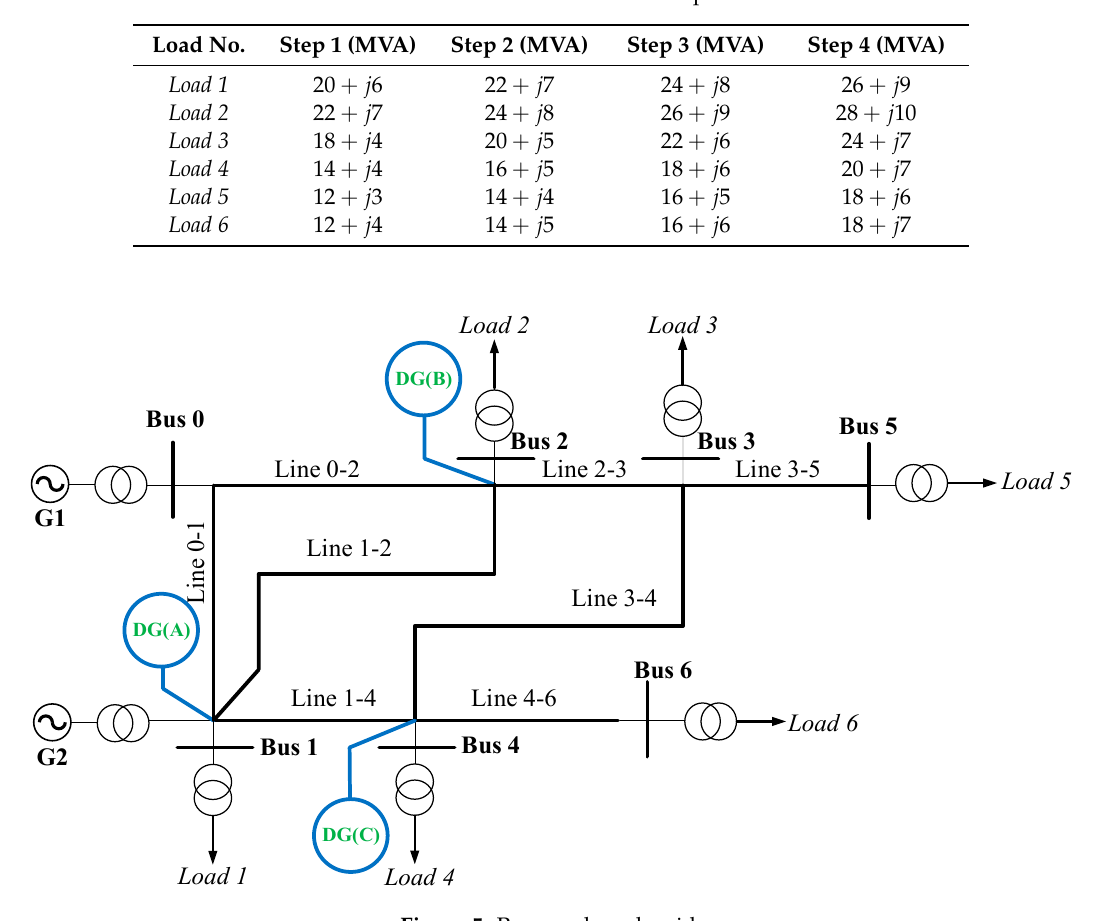
Table 1. Loads values for all steps.